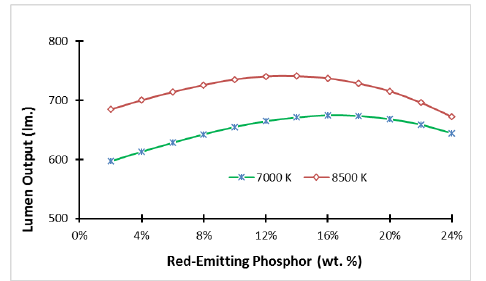
Fig. 7: Color quality scale (CQS) of WLEDs with vari- ous α -SrO · 3B 2 O 3 :Sm 2+ concentration.